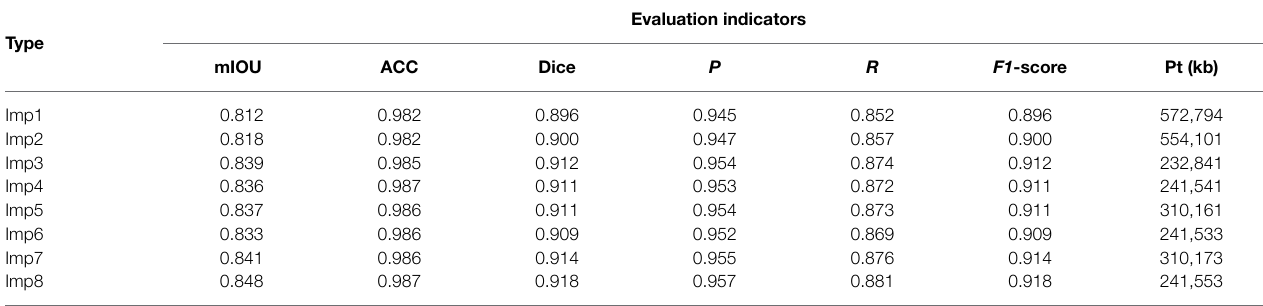
TABLE 4 | Comparison of the test results of different improvement methods of DeepLab v3+.